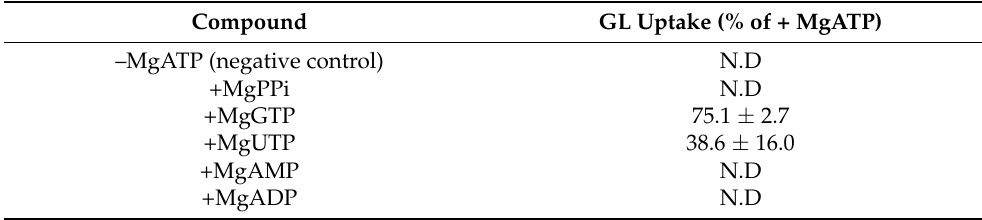
Table 1. Effect of various nucleotides and pyrophosphate on GL uptake. Tonoplast vesicles were incubated with 100 µ M GL in the presence of 5 mM of the compounds listed in the table. Values are presented as the mean ± standard deviation from triplicate cultures. N.D. = not detected.